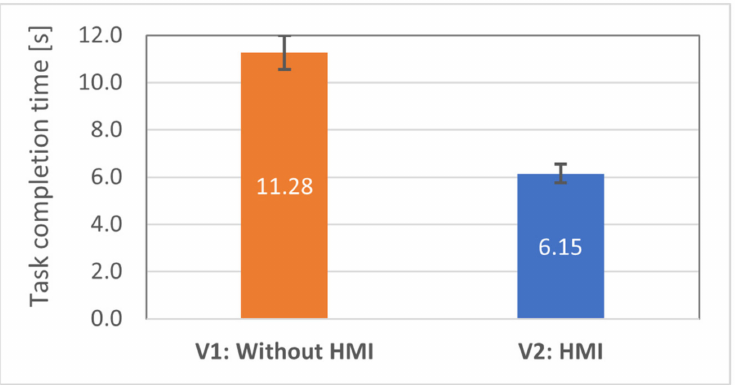
Figure 14. Average task completion time with standard errors for all 16 participants: lower is better. Hypothesis H1.2 stated that the time taken by test subjects to correctly determine the goal position would be similar in all rounds when equipped with HMIs (V2). To investigate the hypothesis, the task completion time for all test subjects was analysed for HMI modes (M = 2.17, SE = 0.37) was significantly lower than for visual inspection (V1: M = 3.30, SE = 0.29), implying that V2 allowed the participants to perform the task distinct in each round—see Figure 15. The deviations were compared using t -test, and statistically significant differences were found, t (15) = 2.27, p < 0.019. This suggests that time for the participants in each round to determine the goal position, thus supporting the H1.2 hypothesis.